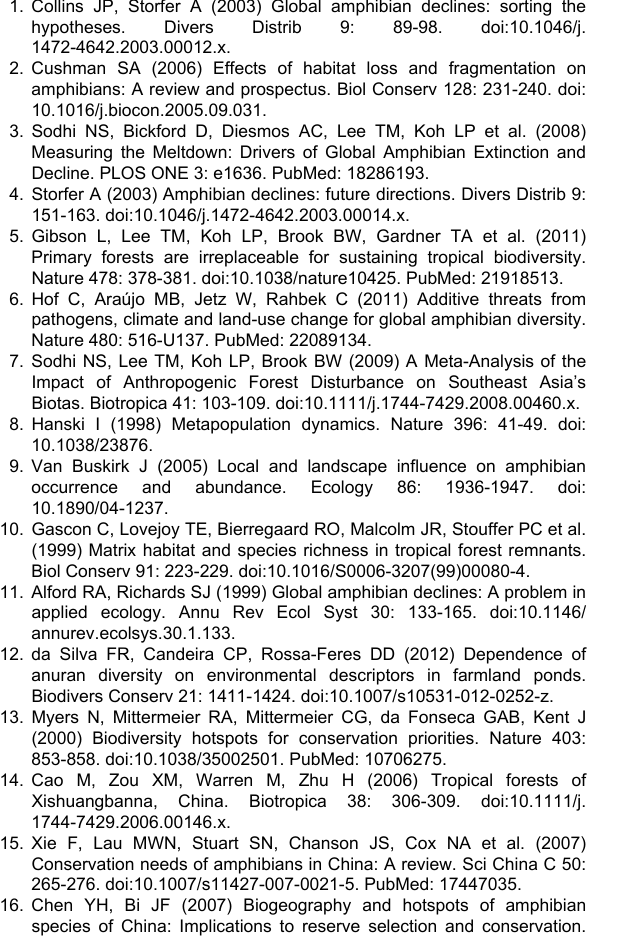
Figure S1. Abundance of individuals encountered in each habitat per week. We encountered more individuals in impacted compared to rubber plantation ( P < 0.001) and rainforest ( P < 0.001) areas, while there was no difference in the number of individuals we encountered in rubber plantation and rainforest areas ( P = 0.19).